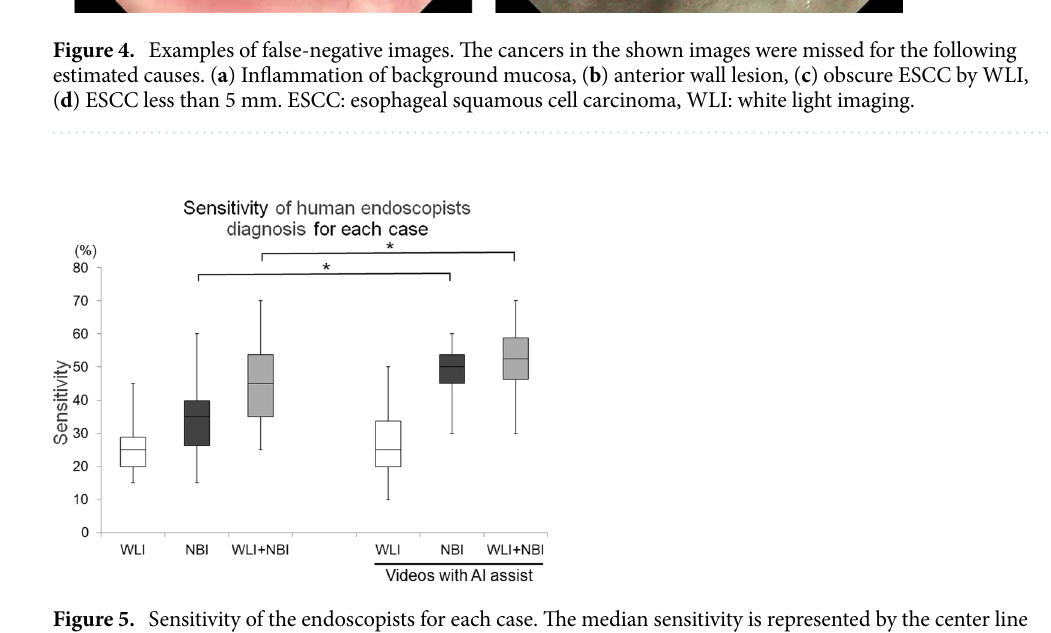
Figure 5. Sensitivity of the endoscopists for each case. The median sensitivity is represented by the center line in the box, which indicates the IQR. The range is indicated by whiskers. When diagnosed with either WLI or NBI, we considered the endoscopists to have detected the cancers (WLI + NBI). IQR: interquartile range, WLI: white light imaging, NBI: narrow-band imaging. *P <